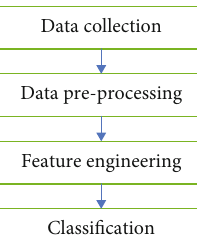
Figure 1: Sarcasm detection